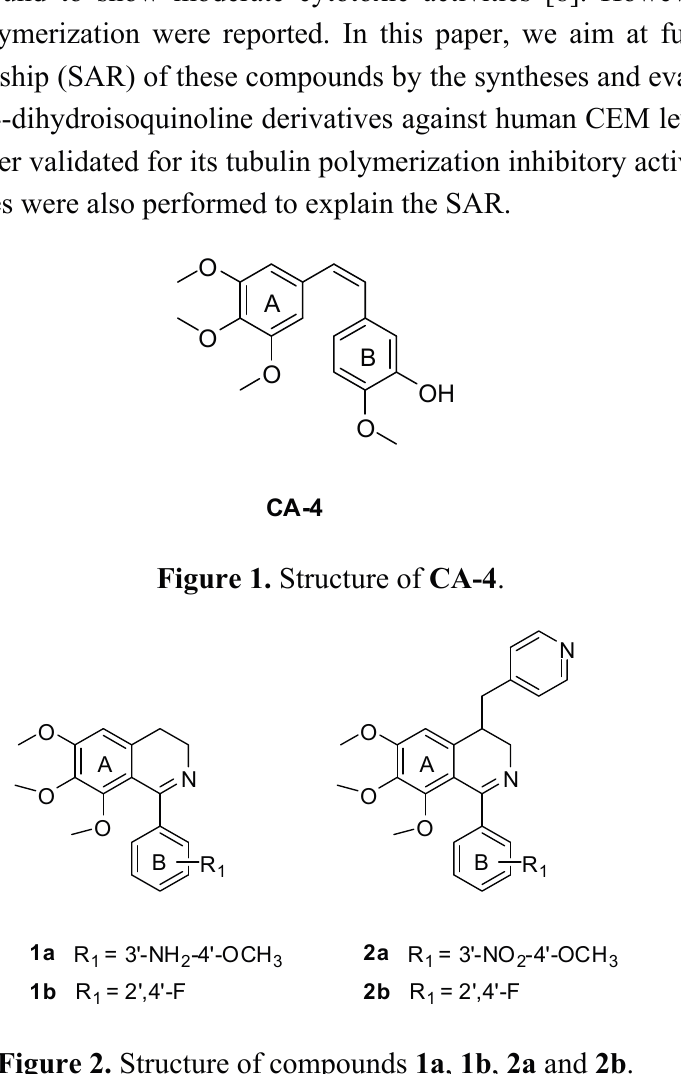
Figure 2. Structure of compounds 1a , 1b , 2a and 2b